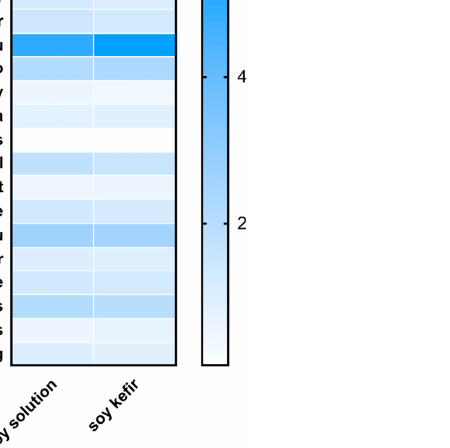
Figure 7. Amino acid profiles of the soybean solution and soybean kefir.